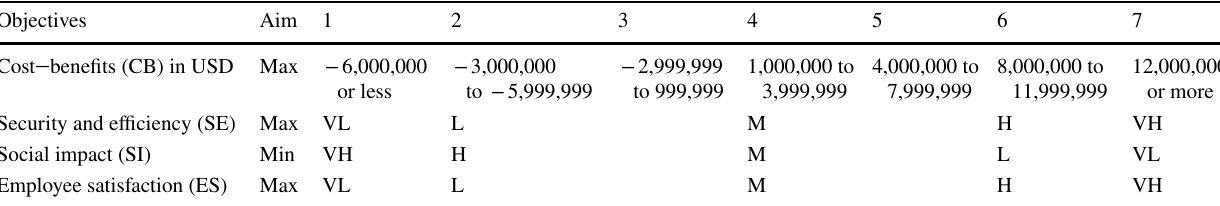
Table 1 The weighted sum method scorecard